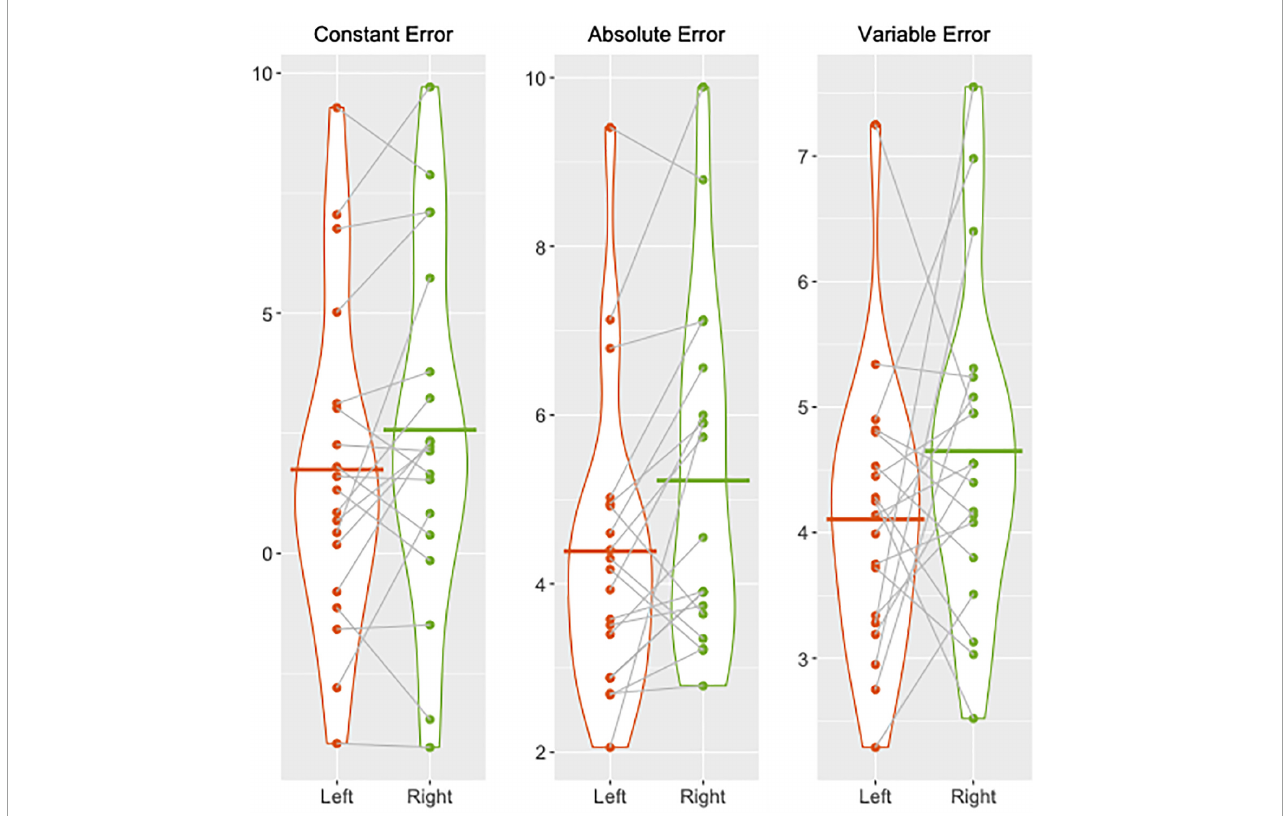
FIGURE1 Violin plots illustrating group and individual mean knee joint position sense errors (constant, absolute, and variable) in degrees of knee flexion for the left (red) and right (green) legs. Individual means are depicted by the dots and the corresponding means for each leg are joined together by dotted lines. Group means for the left and right legs are shown by the solid red and green lines,